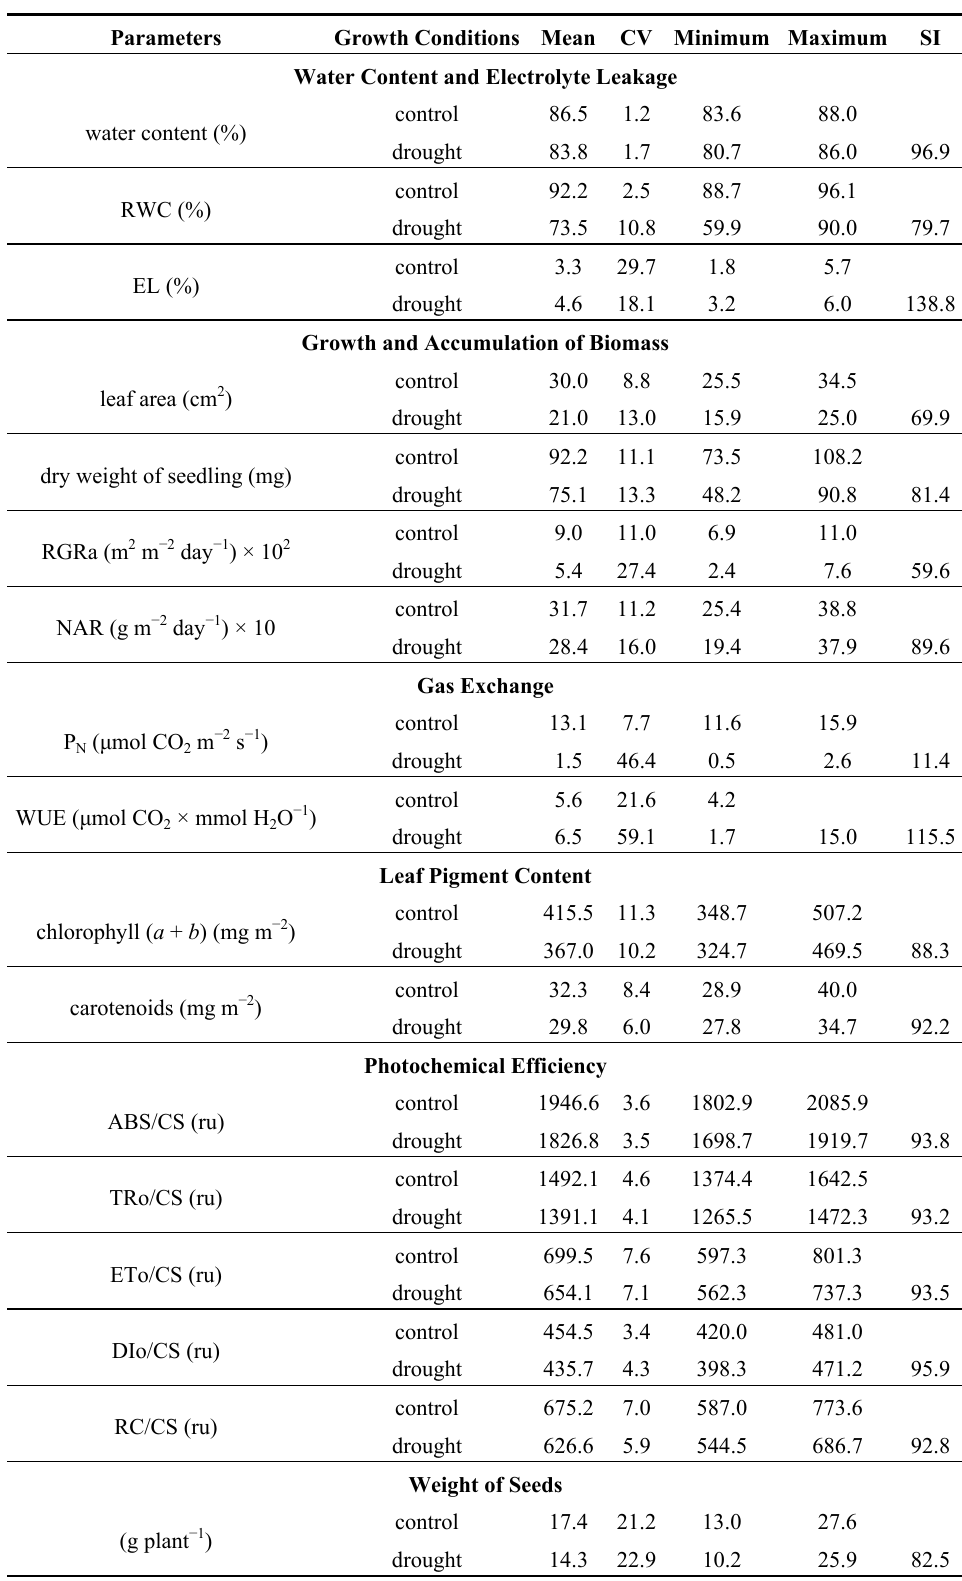
Table 1. The mean, variation coefficient (CV), the maximum and minimum values of the mean and stress index (SI as percentage of control) of physiological parameters of seedlings and the final yield of grain wheat varieties at optimal soil moisture and after the drought stress. Values calculated on the basis of the means for 20 varieties ( N =